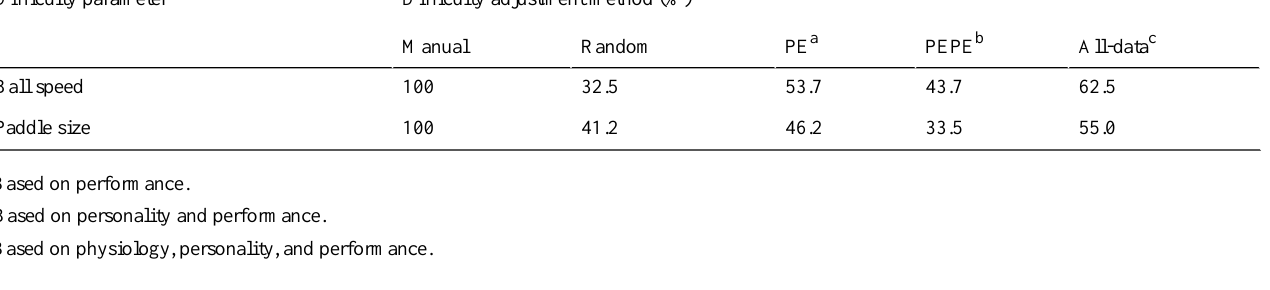
Figure 4. Ball speed (left) and paddle size (right) of five dynamic difficulty adjustment methods for nine 2-minute game intervals across 10 participants. Error bars indicate 95% CI. PE: based on performance; PEPE: based on personality and performance; all data: based on physiology, personality, and